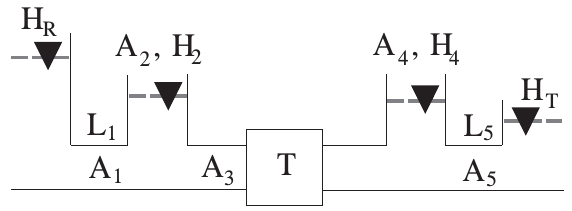
Figure 3. Scheme of the hydroelectric